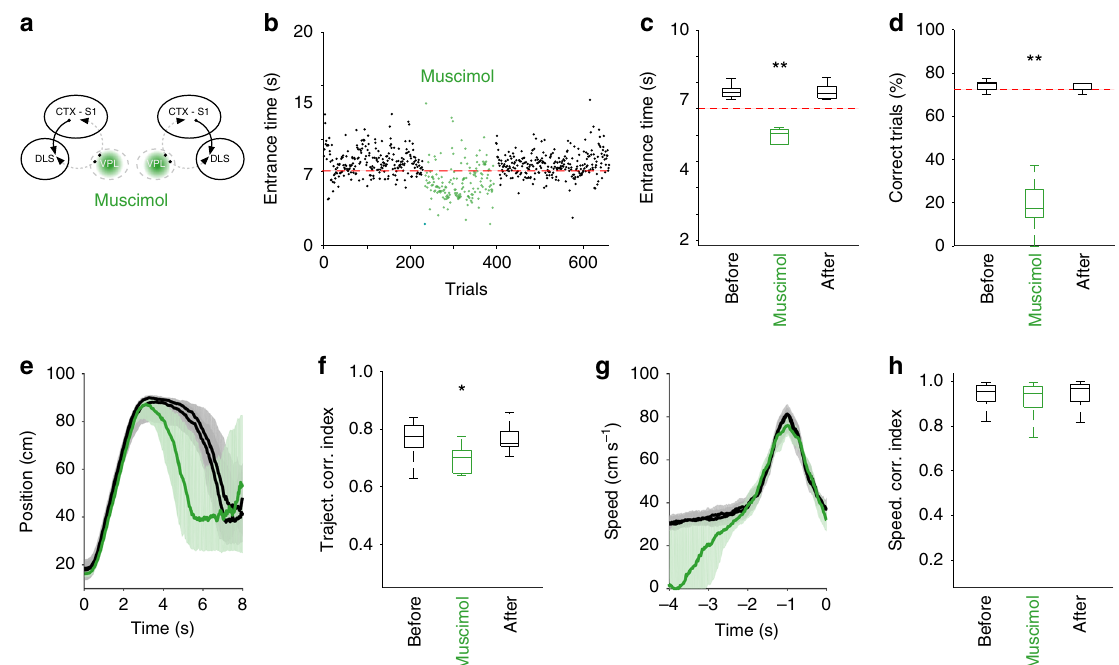
Fig. 6 Effects of pharmacological inactivation of theVPL. a Schematic representation of the VPL inactivation procedure. b Goal area entrance times for four sessions before and after (black) the administration of muscimol in the VPL (green, 50 ng in 0.5 μ l). The different phases of the sequence are indicated in the average trajectory. c Group effect for muscimol injections on entrance times ( c ) and percentage of correct trials ( d ) (median + 75th and 25th percentiles). Representative position ( e ) and speed ( g ) trajectories and group effects on position ( f ) and speed ( h ) before and after (black) muscimol (green). * P < 0. 01, ** P < 0.001, Kruskall – Wallis and Tukey ’ s HSD test ( c , d , f , h